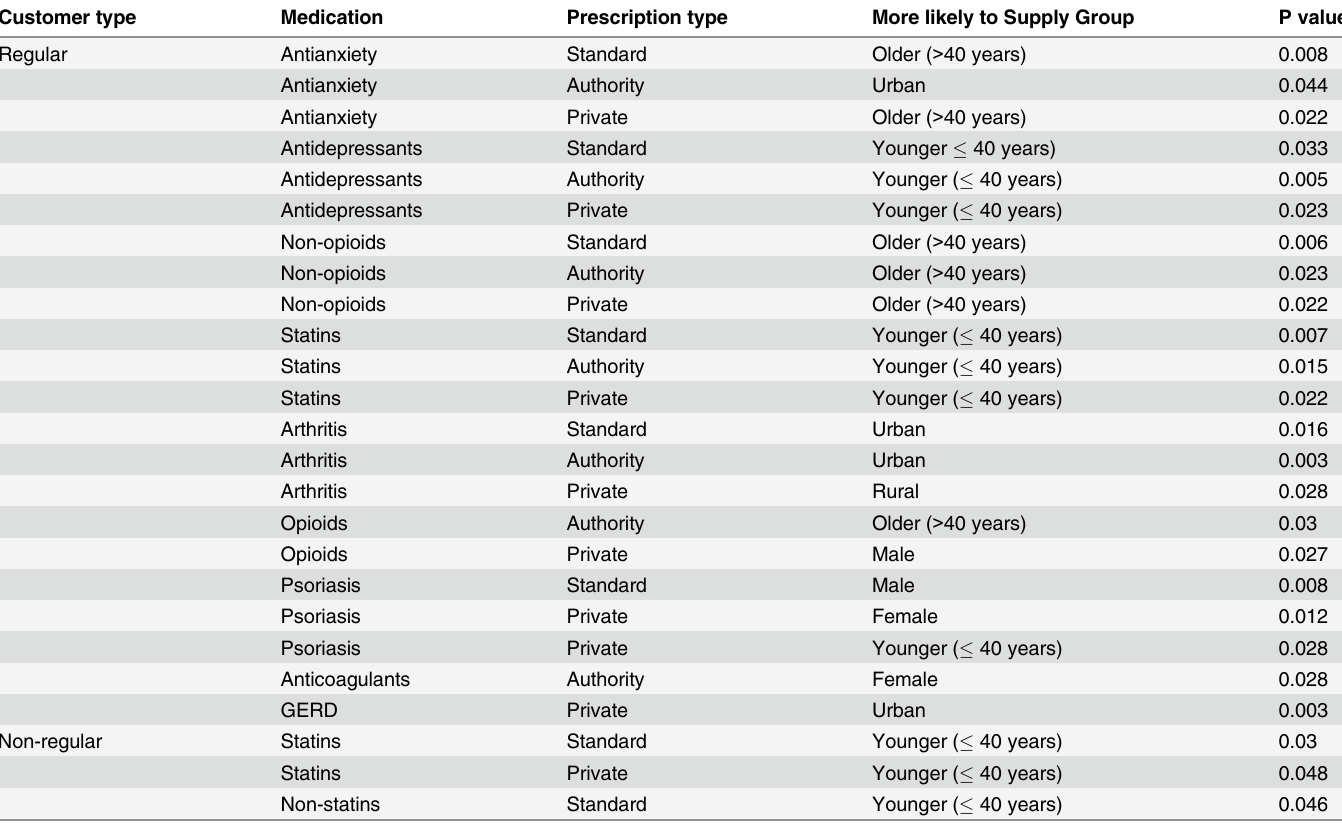
Table 2. Effects of demographic variables on participants ’ decisions to supply (n =